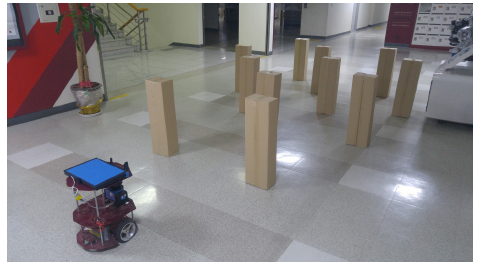
Figure 8. The experimental